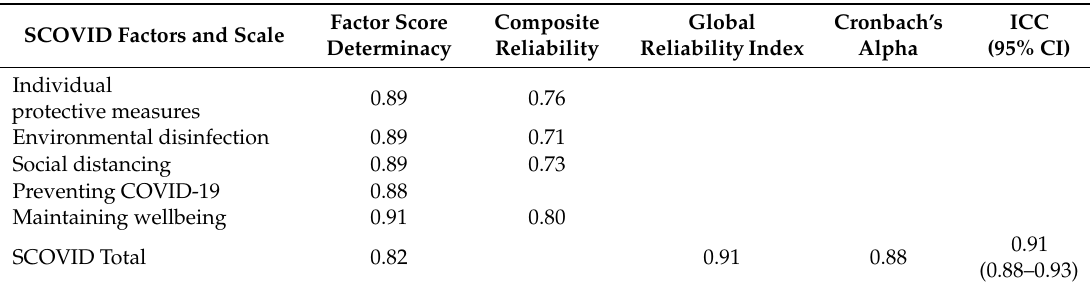
Table 4. Reliability of the SCOVID